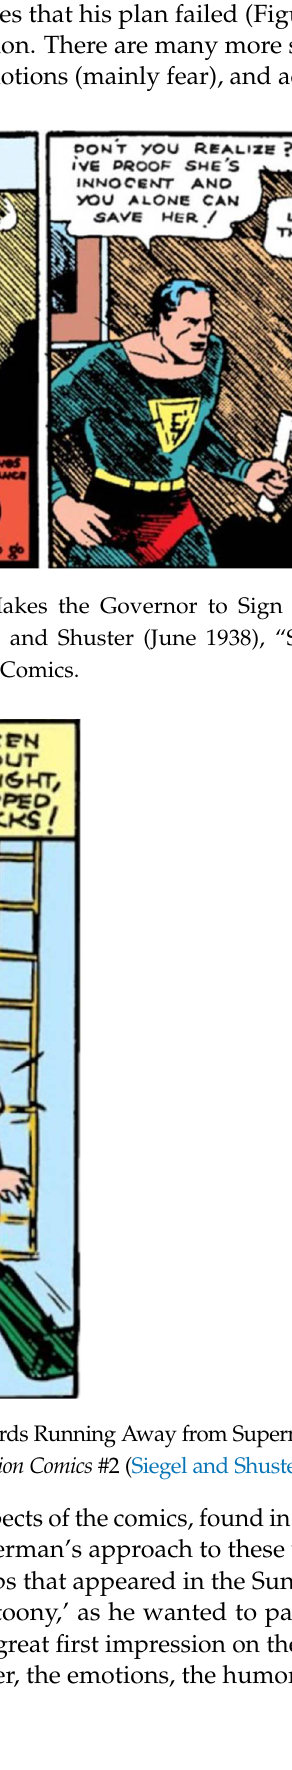
Figure 12. Joe Shuster, Close-Up of the Munitions Manufacturer Pressing a Button (panel No. 8), 1938. Siegel and Shuster (July 1938), “Superman”, Action Comics #2 (Siegel and Shuster 1938b, p. 23). © DC Comics.